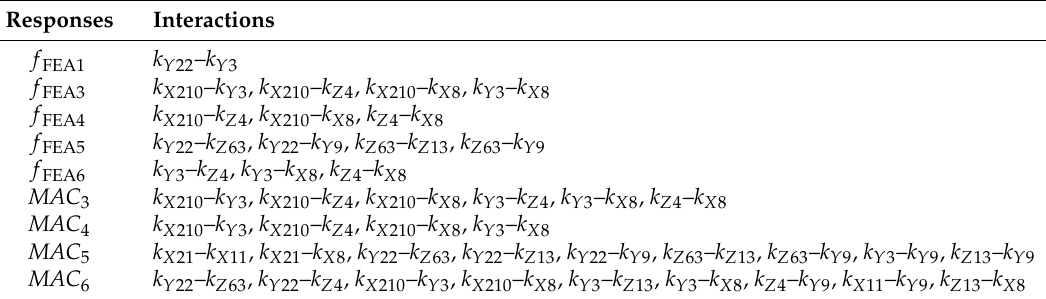
Table 7. Summary of two-factor interactions affecting